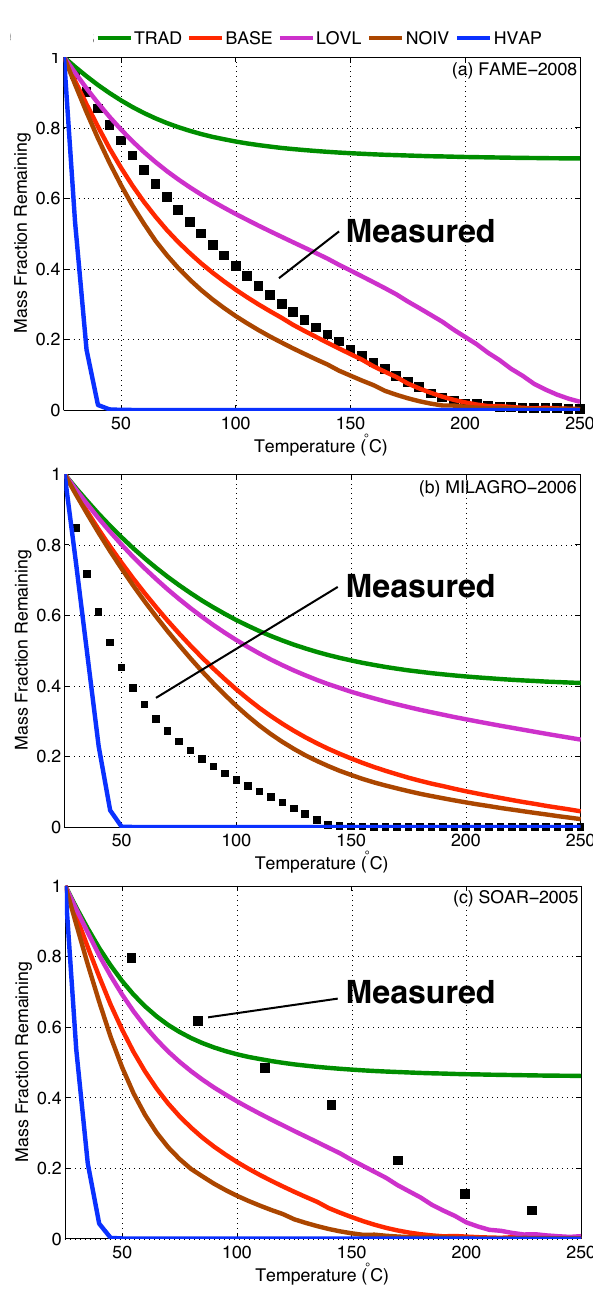
Fig. 9. Thermograms comparing equilibrium-corrected data from the (a) the FAME-2008 campaign and (b) MILAGRO-2006 cam- paign with model results. (c) Thermogram comparing raw mea- sured data from SOAR-2005 with model results. Data are from Lee et al. (2010), Cappa and Jimenez (2010) and Huffman et al. (2009b).